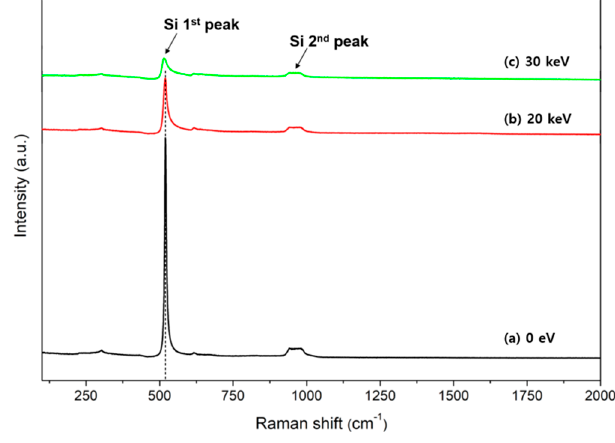
Figure 1. Raman spectra after the irradiation of electron beams with acceleration voltages of ( a ) 0 eV, ( b ) 20 keV, and ( c ) 30 keV for 24 h around the aperture hole of the Si electron lens fabricated using the micro electro-mechanical system (MEMS) process.